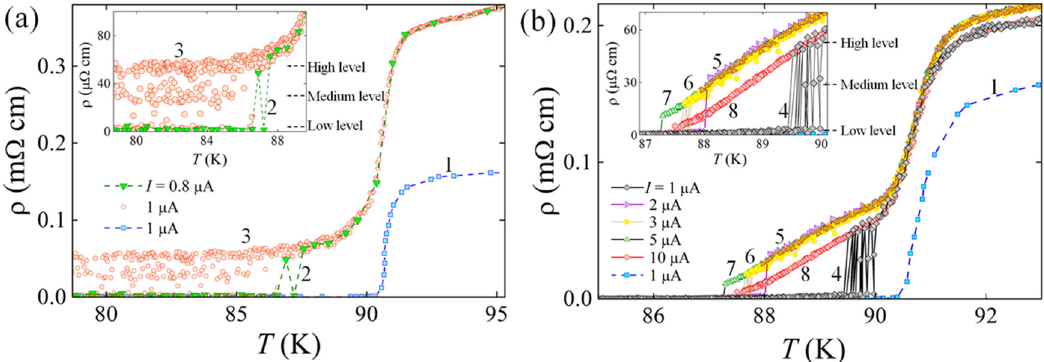
Figure 2. Resistivity versus temperature ρ ( T ) dependences of YBa 2 Cu 3 O 7- δ samples with partially deoxygenated structures (straight and rectangle lines) exhibiting the properties of a weak superconductor: ( a ) optically modified sample 1 biased with I = 0.8 µ A (2) and 1 µ A (3); ( b ) sample 2 biased with I = 1 µ A (4), 2 µ A (5), 3 µ A (6), 5 µ A (7), and 10 µ A (8). Curve 1 in both graphs represents the same ρ ( T ) dependence of reference sample (having no partially deoxygenated lines) measured at I = 1 μ A.